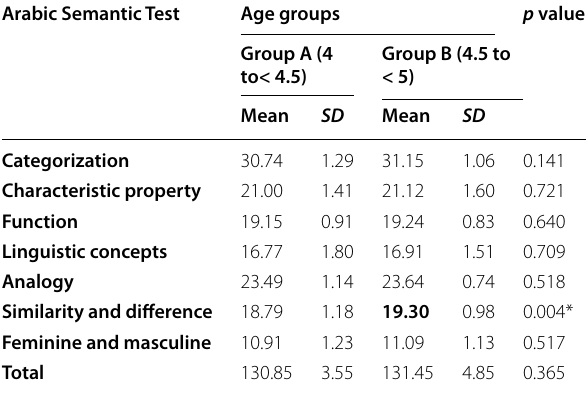
Table 2 Comparison between the two age groups regarding total and subtotal scores of the Arabic Semantic Test